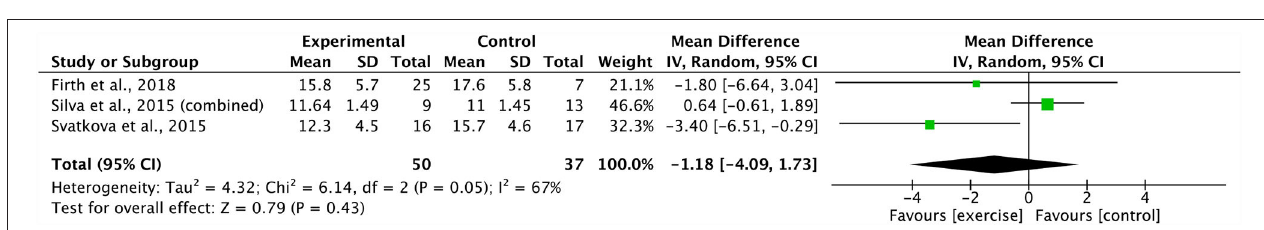
FIGURE 7 | The effects of combined aerobic and resistance training on PANSS positive scores.